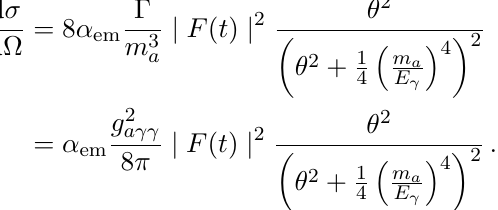
by g loop in the Primakoff aγγ aγγ